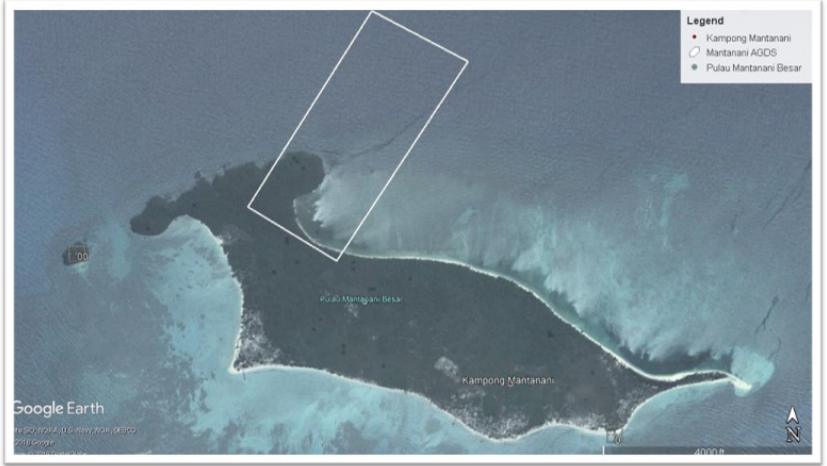
Figure 4. The ADCP Deployment of Northeast Mantanani Besar Island.